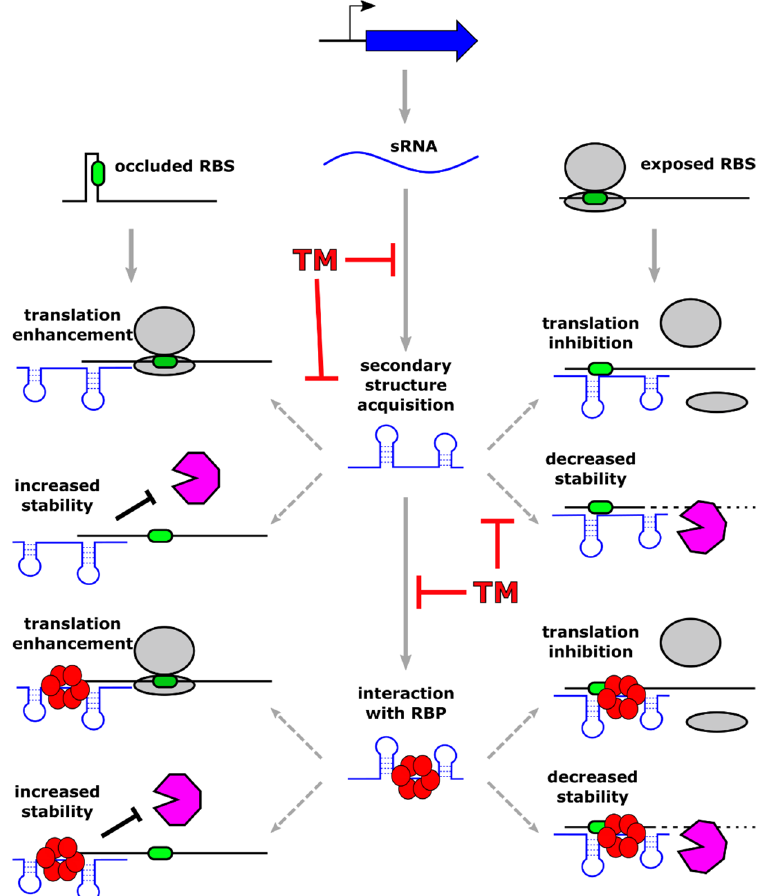
Figure 2. Schematic representation of the principal mechanisms of action used by base-pairing regulatory sRNAs and possible targeting strategies through antisense short oligonucleotides. A regulatory sRNA binds one or more target transcripts with or without the assistance of an RNA-binding protein (shown as red circles forming a hexamer associated to the sRNA). This interaction results in either positive or negative modulation of gene expression. Left side of the figure: positive regulation occurs when sRNA binding leads to increased ribosome binding site (RBS, represented by a green oval) accessibility and/or protection of the transcript from RNase (depicted by a pink polygon) processing. Right side of the figure: negative regulation of gene expression takes place when sRNA interaction with the target transcript occludes the RBS, preventing ribosome loading (ribosomes are represented by two grey ovals), and/or promoting RNase-mediated processing. Novel sRNA-targeting molecules (indicated with the symbol “TM” in the figure) could act in principle in several ways, affecting the different steps of sRNA-mediated regulation.